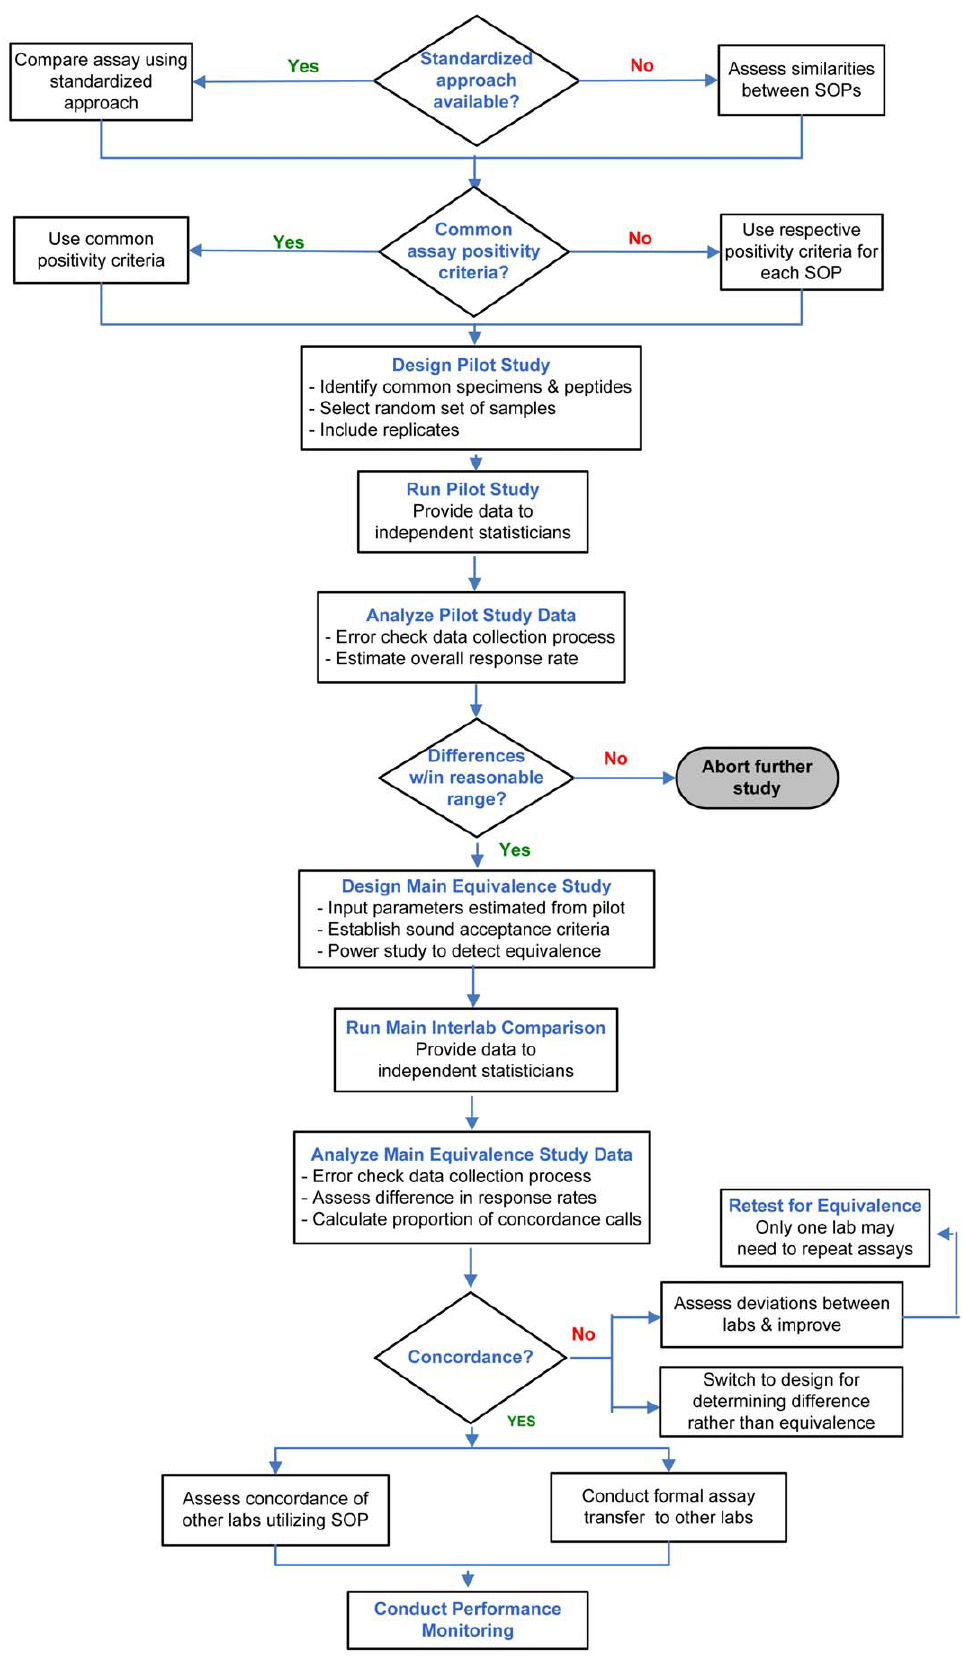
Figure 1. CTC-VIMC/VISC ELISpot Standardization Methodology. doi:10.1371/journal.pone.0014330.g001 PLoS ONE |